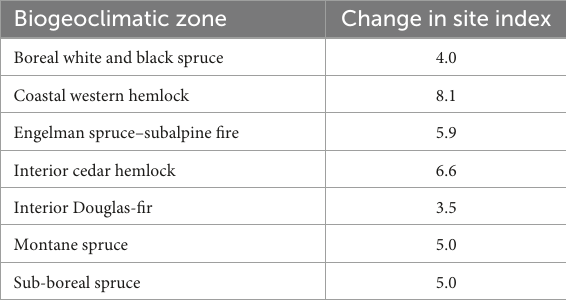
Estimatesofchangetakenfromamixedeffectsmodelwiththesiteasarandomeffect.